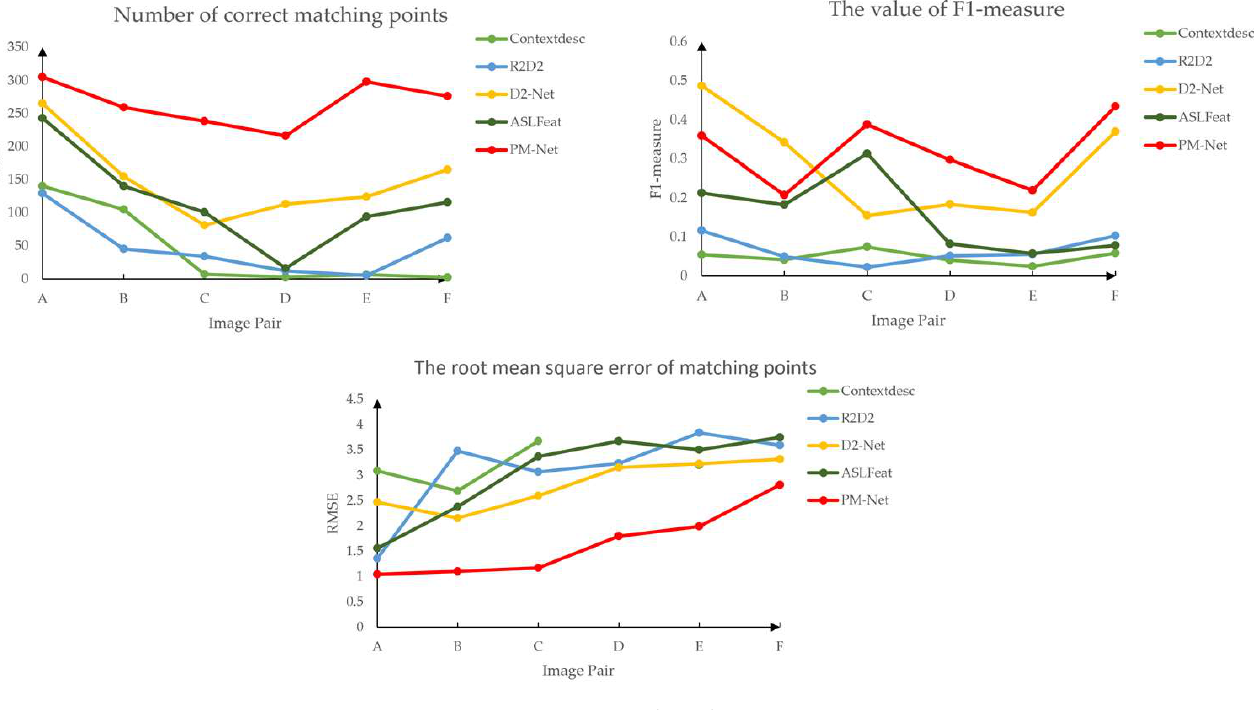
Figure 12. Quantitative experimental results.